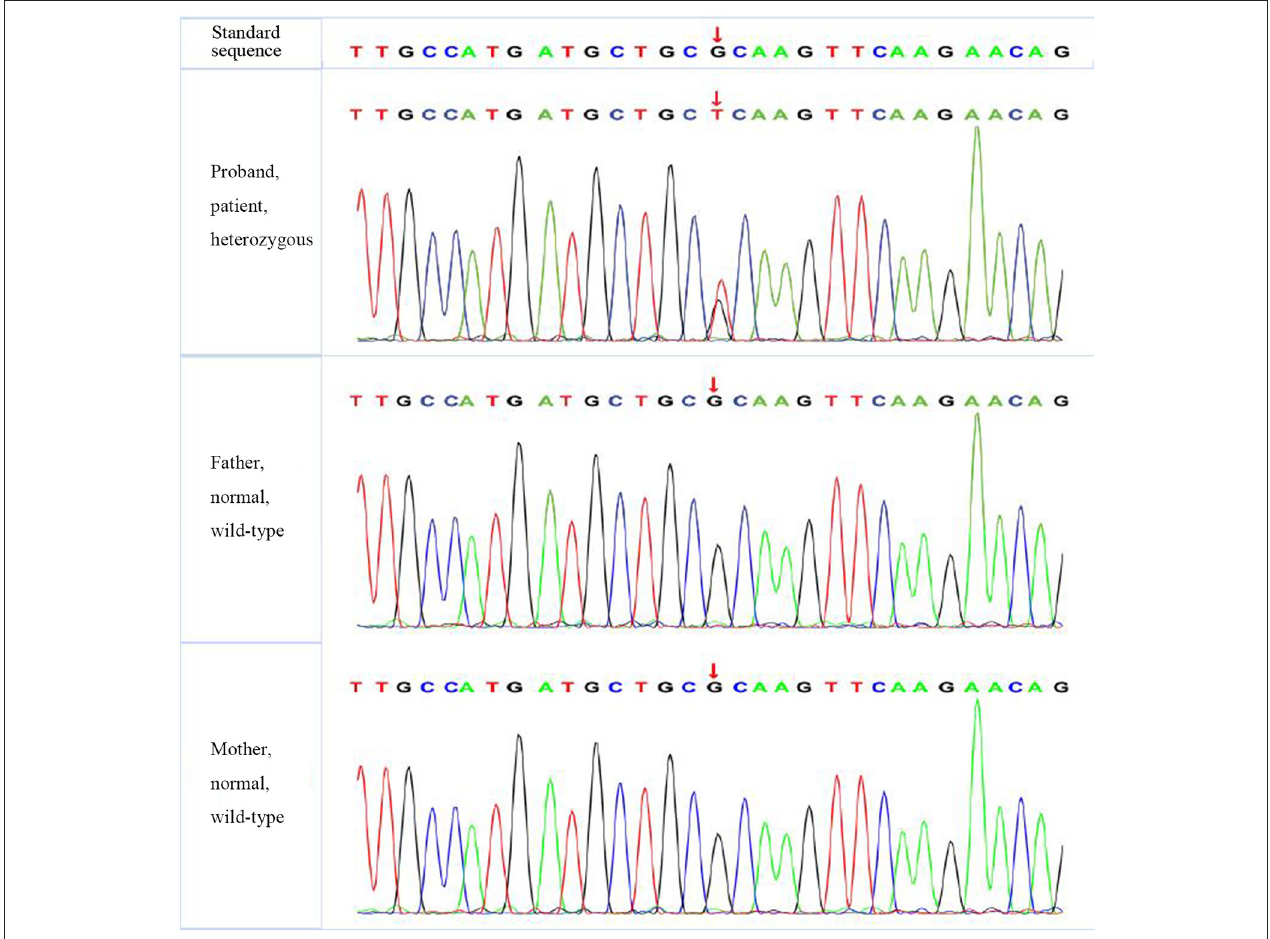
FIGURE 1 | The verification results of SLC4A1 . SLC4A1 :c.1766 (exon 14) G >